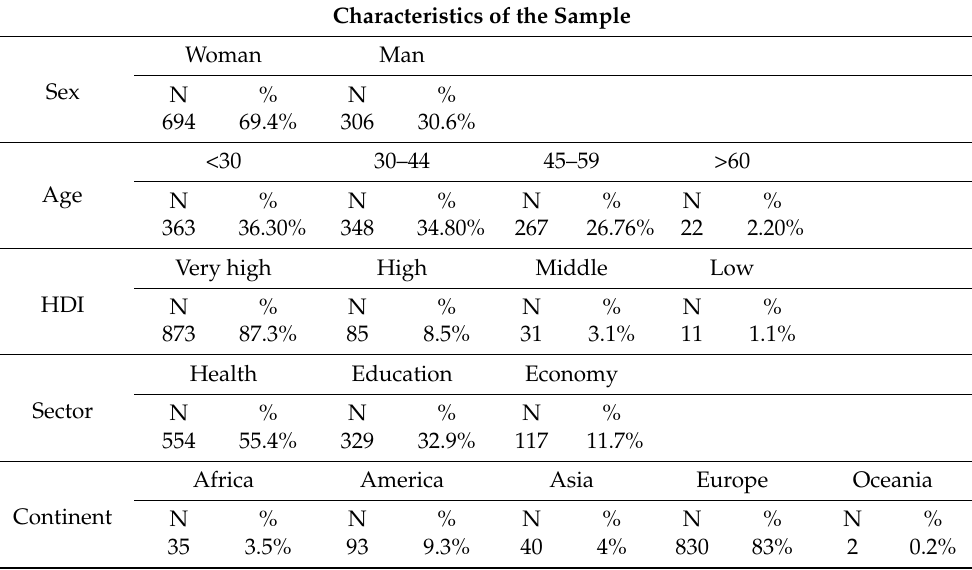
Table 1. Characteristics of the sample according to Sex, Age, HDI, Sector and Continent. Characteristics of the